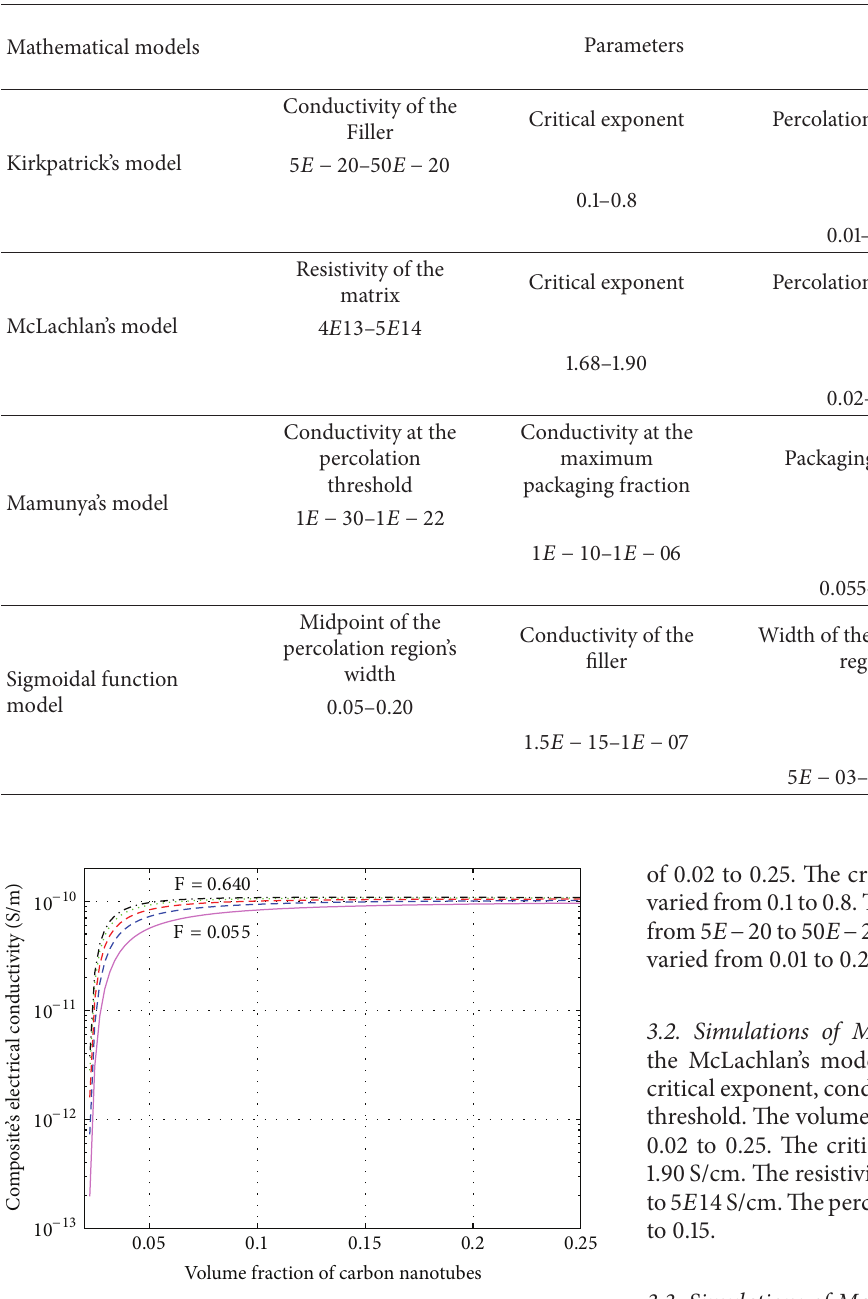
Figure 18: DC electrical conductivity of the nanocomposite when the packaging fraction of the filler is varied (Mamunya’s